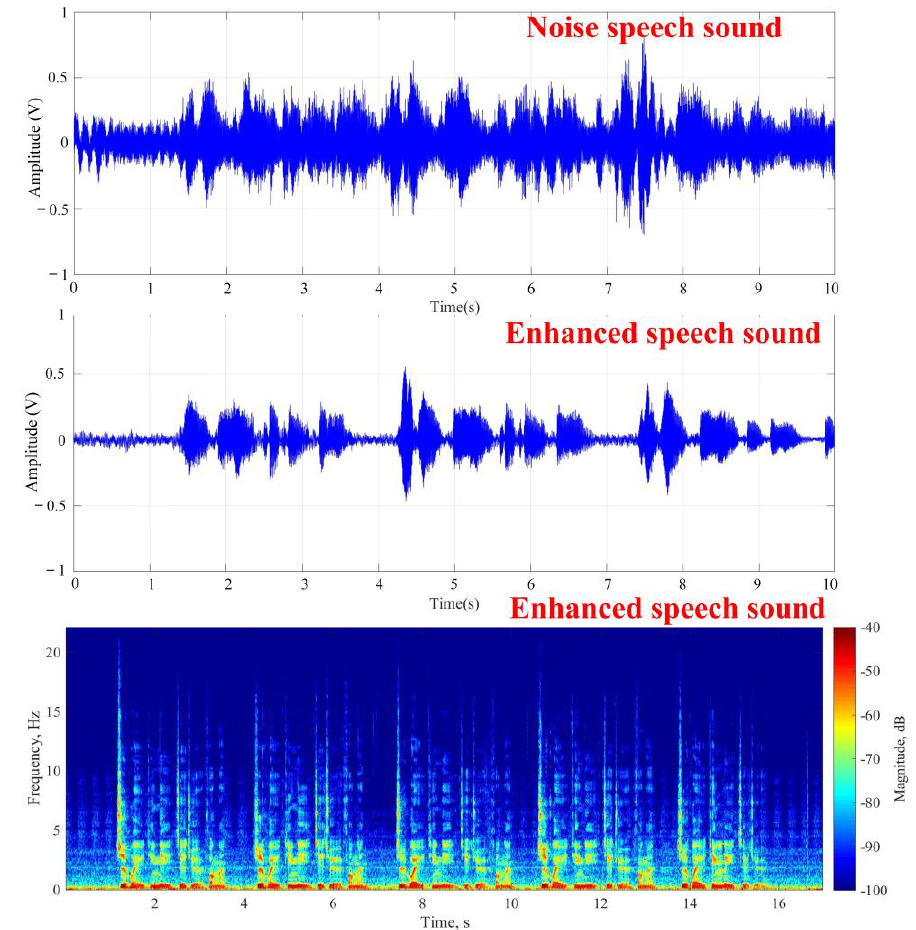
Figure 10. Results of target speech enhancement in various noise environments.